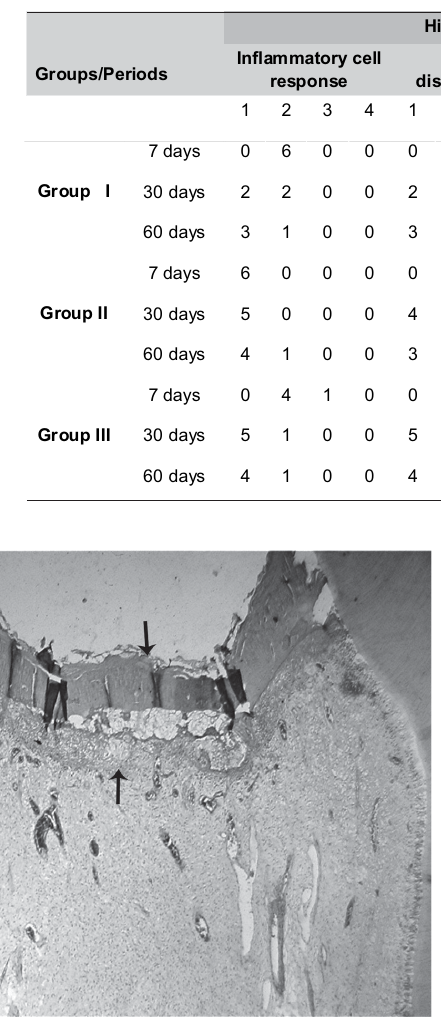
Fig. 1 - (Group II; 7th day ) - Pulpotomy zone with large coagulation necrotic area between material and pulp tissue (arrows). Presence of few inflammatory cells and small congested and dilated blood vessels in subjacent pulp tissue. Hematoxylin-eosin, original magnification 32X.